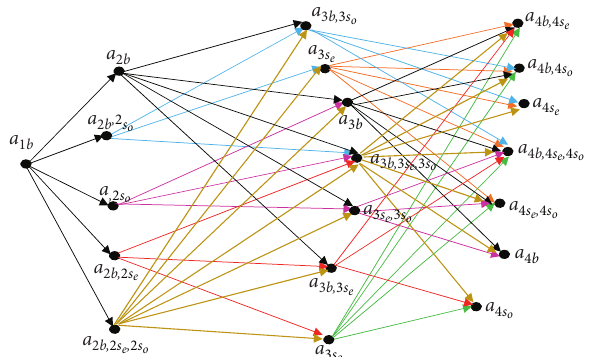
Figure 5: The position of coupling the vertex and edges according to the body, soul odd, and soul even parts for the logarithmic spiral.